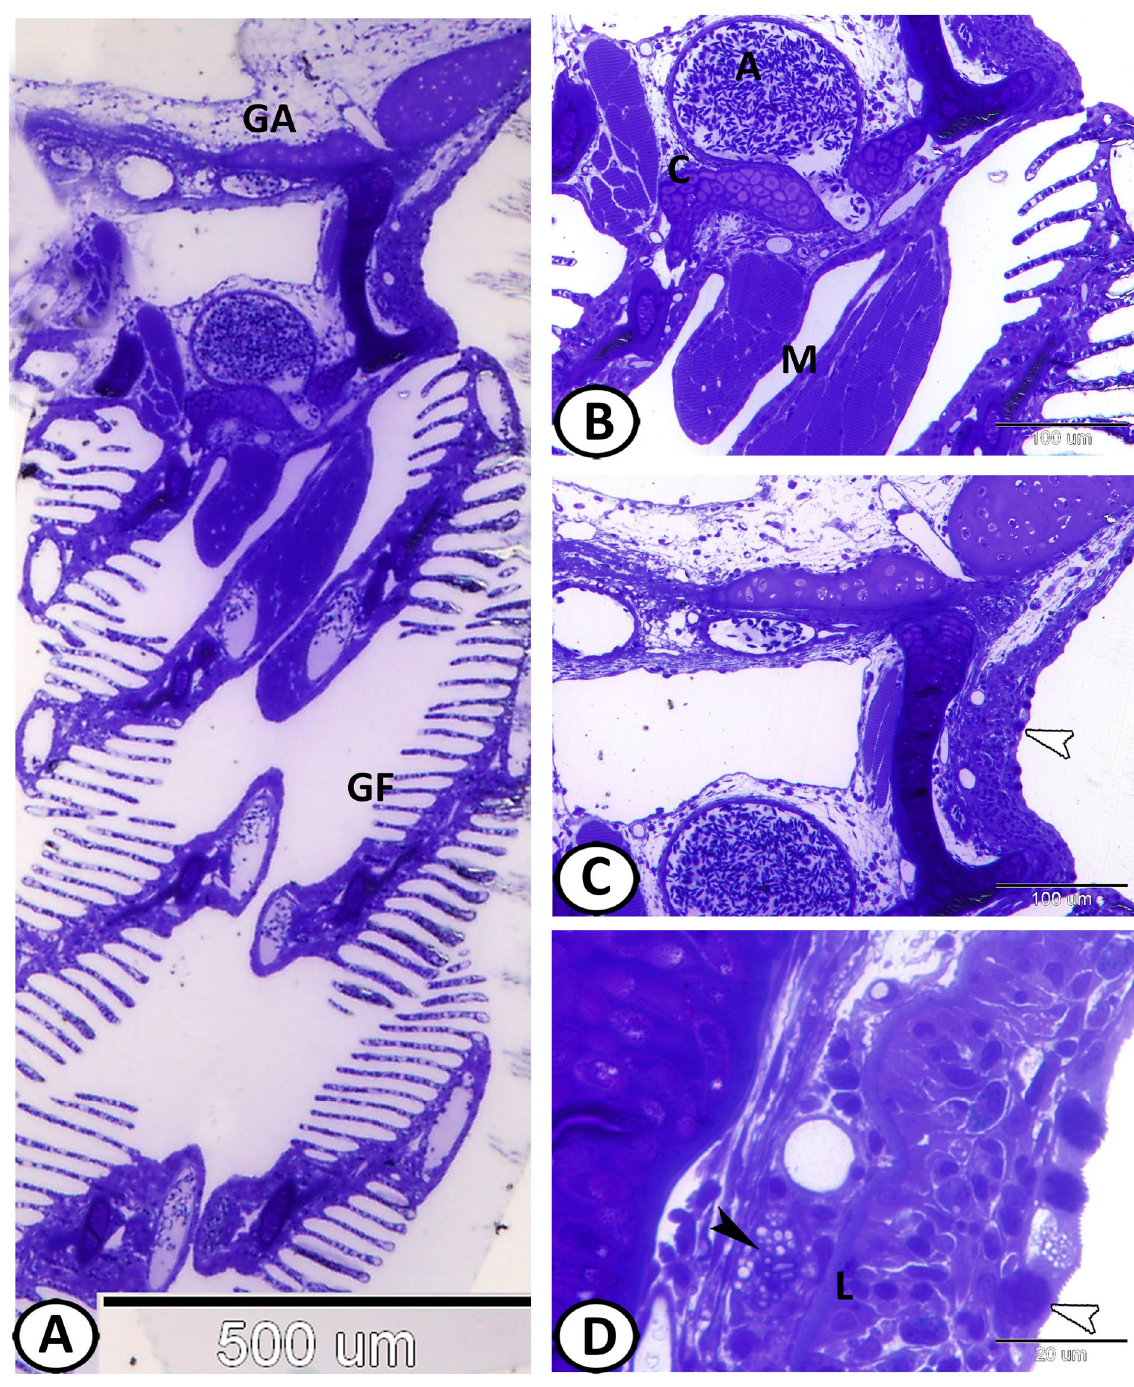
Figure 2. Semithin sections stained with toluidine blue. ( A ) The cartilaginous core of the gill arch (GA) extends to the gill filaments (GF). ( B ) Higher magnification of ( A ) shows the presence of afferent artery (A) with supported cartilage (C) and skeletal muscle fibers (M). ( C , D ) The covering epithelium of the gill arch consisted of stratified epithelial cells with apical mucous cells (white arrowhead) and basal lymphocytes (L). Note the presence of a bundle of nerve fibers (black arrowhead).